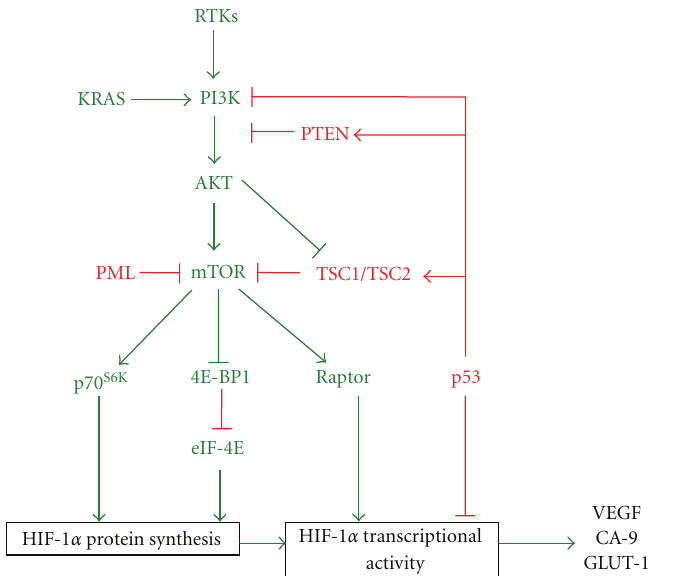
Figure 3: Regulation of HIF-1 α by the PI3K pathway. Stimulation of receptor tyrosine kinases (RTKs) by growth factors or activating mutations in the RAS family of GTPases, such as KRAS, results in activation of PI3K. Activated PI3K enables the phosphorylation and activation of AKT. AKT in turn activates mammalian mTOR by disrupting the inhibitory interaction of the TSC1/TSC2 complex with mTOR. mTOR enhances HIF-1 signalling in a multimechanistic way (a) By activating the translational machinery proteins p70 S6K and EIF- 4E leading to enhanced protein synthesis of HIF-1 α and (b) By promoting the interaction of HIF-1 α with the coactivator p300, possibly by direct phosphorylation of HIF-1 α via interaction with the sca ff old protein raptor. Additionally, deletion or loss of function of negative regulators of the PI3K pathway leads to enhanced signalling and activation of HIF-1. These include PTEN, p53, PML, and TSC1/2. The phosphatase PTEN dephosphorylates the products of PI3K, inhibiting activation of AKT and subsequent downstream targets. p53 inhibits PI3K signalling at multiple levels; p53 inhibits transcription of the catalytic subunit of PI3K (p110 α ), enhances transcription of PTEN and TSC2, interacts with HIF-1 α , and recruits MDM2, targeting HIF-1 α for proteosomal degradation. PML inhibits mTOR under hypoxia and TSC1/2 interacts with and prevents activation of mTOR in the absence of PI3K